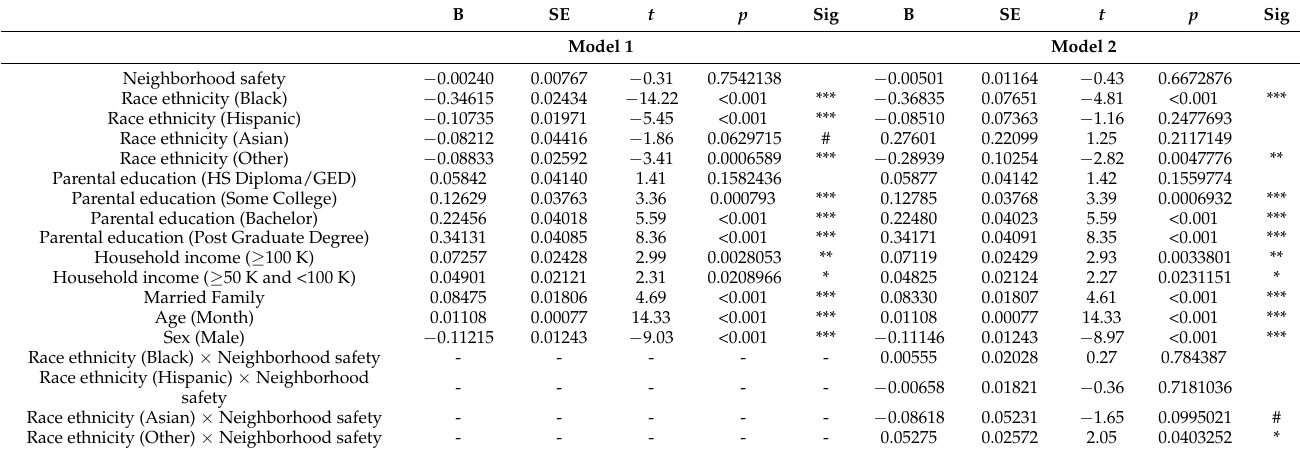
Table 5. Summary of mixed-effects regressions on the association between parent’s neighborhood safety and children’s cognitive performance (learning and memory) overall and by